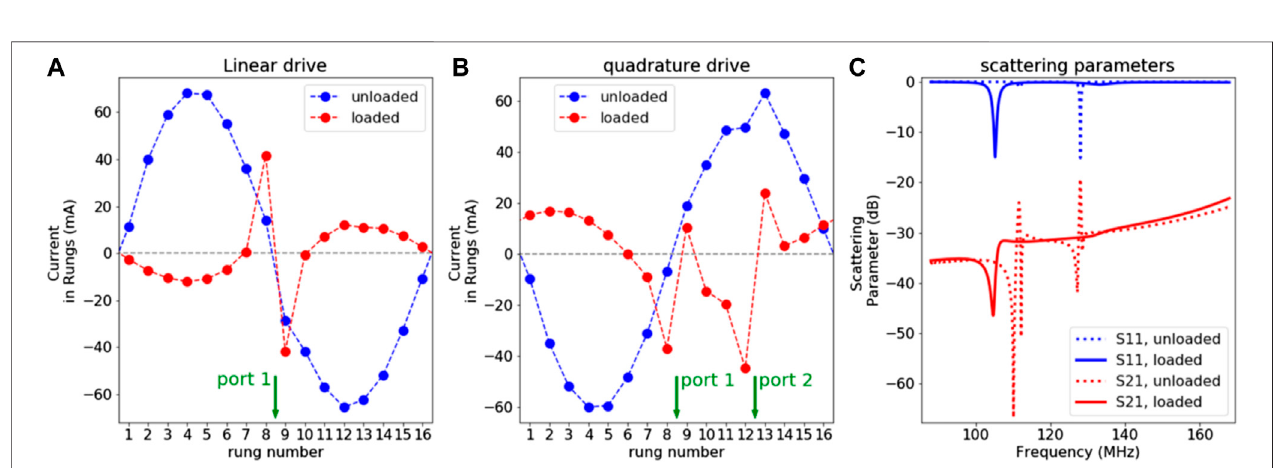
FIGURE8|(A) Currentdistributionsintherungsofthebirdcagewithmagnetic(PMC)shieldinloaded(frequency (cid:1) 133 MHz)andunloaded(frequency (cid:1) 128 MHz) conditions, with one port active. (B) Idem with two ports active, driven in quadrature. The currents were calculated from the electric and magnetic fi elds by numerically integratingtheAmpère – Maxwellequationoverarectangularpath(inthecentraltransverseplane)enclosingtherung.Hereshownistherealpartofthephasor.Allresults are normalized to 1 W of accepted power. (C) Scattering parameters of the birdcage with magnetic shield in loaded and unloaded situations.